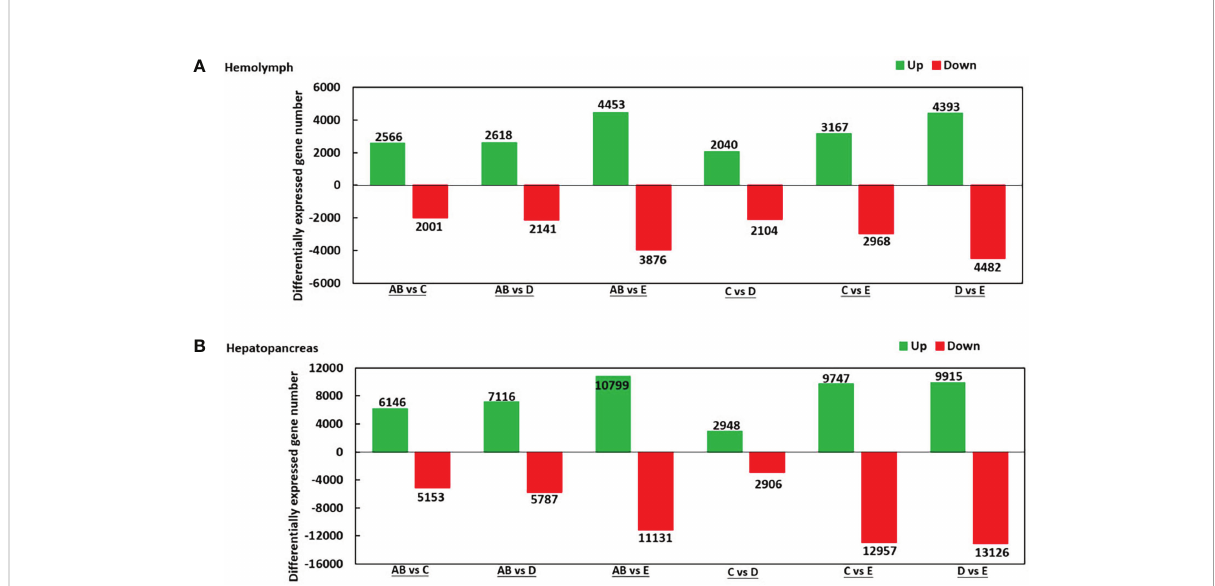
FIGURE 2 Summary of differentially expressed genes (DEGs) in transcriptome of hemolymph (A) and hepatopancreas (B) of P. trituberculatus . Notes (1): AB: post-molt; C: inter-molt; D: per-molt; E: ecdysis (2). Up- and downregulated genes are shown in green and red, respectively (3). The x -axis shows the comparisons between two stages, whereas the y -axis represents the total number of DEGs for each comparison. The numbers on the columns represent the number of